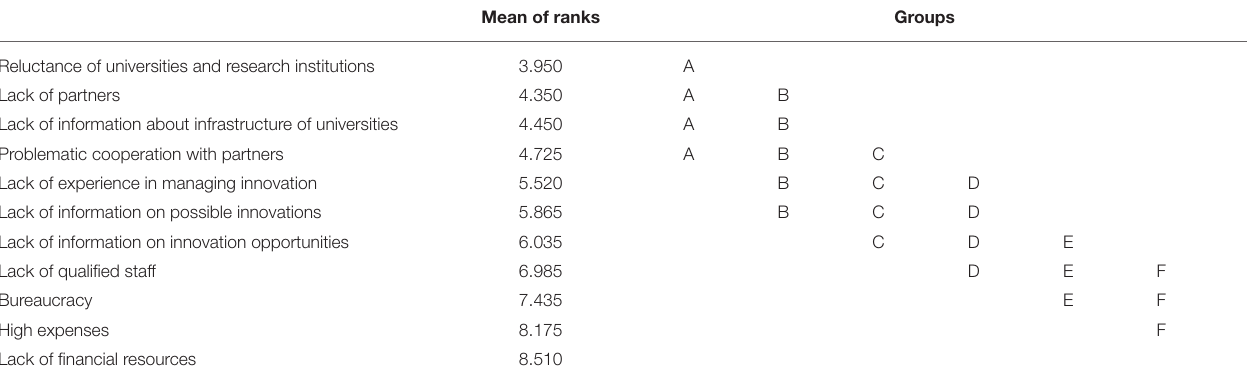
TABLE 1 | Barriers to